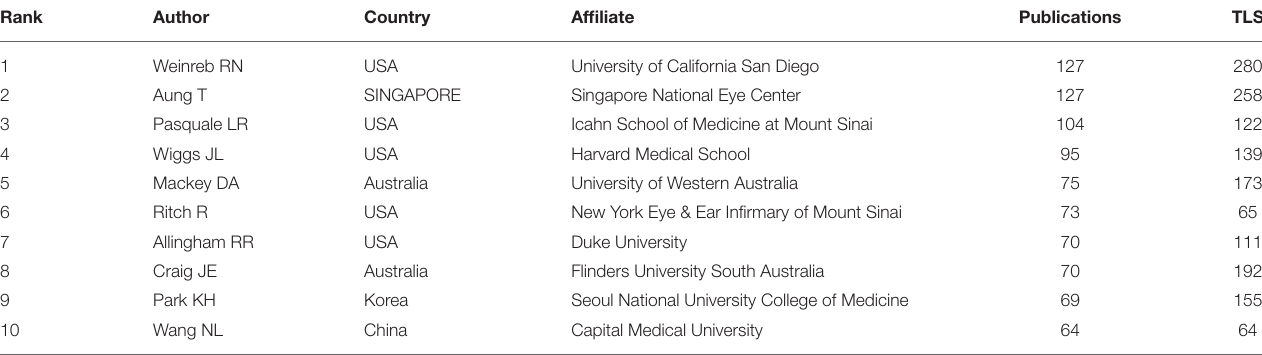
TABLE 1 | The top 10 authors in the study of POAG.